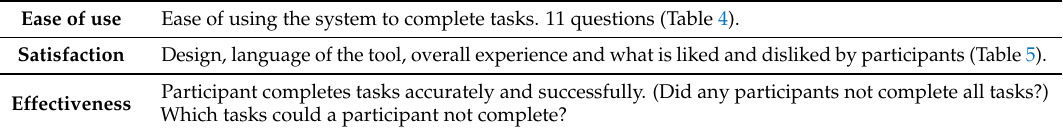
Table 3. Definition of three factors used to compare between users and non-users. Ease of use Ease of using the system to complete tasks. 11 questions (Table 4).